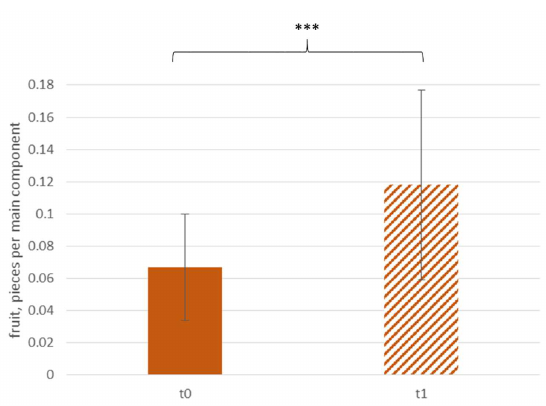
Figure 5. Daily sale of fruit per main component according to time; *** p < 0.001.